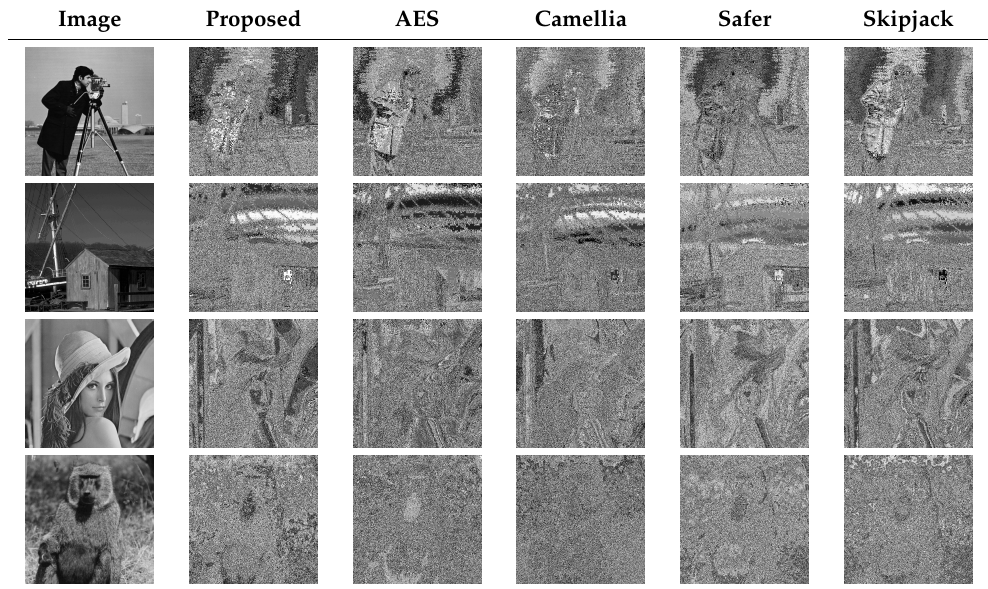
Table 10. Original image and encrypted versions using different substitution boxes.